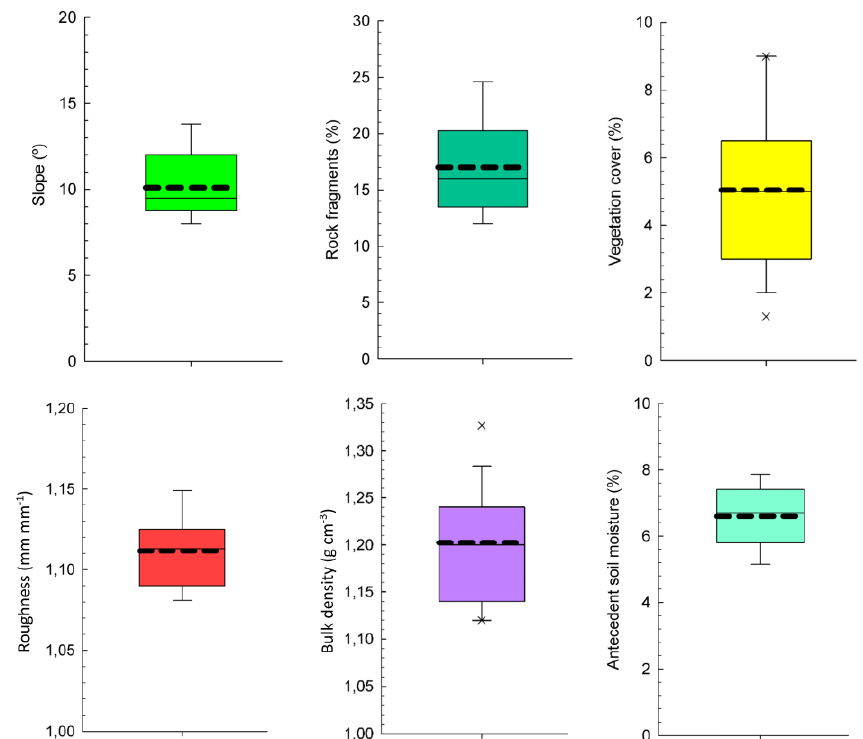
Figure 3. Environmental plot characteristics depicted in box plots.